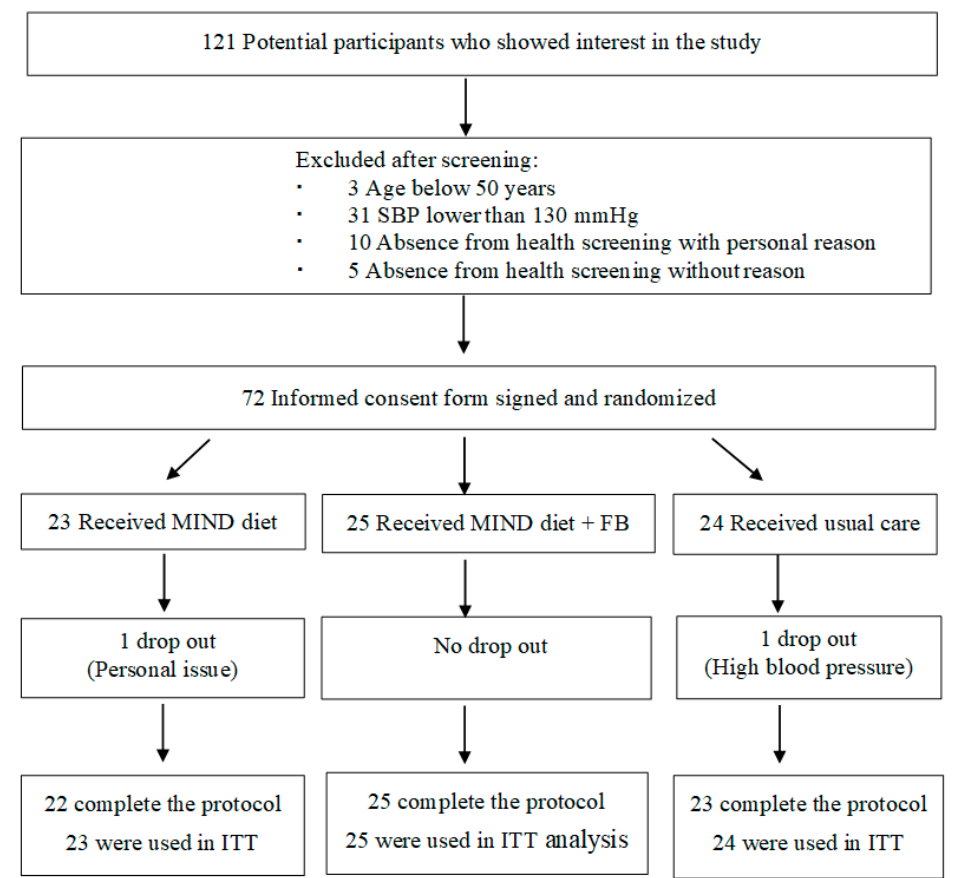
Figure 2. flowchart of the participant selection process in the study period. Figure 2. Flowchart of the participant selection process in the study period. Table 2. Baseline socio-demographics and lifestyle characteristics of study subjects (ITT